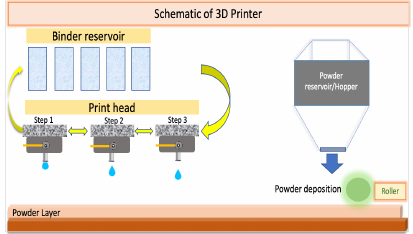
Fig. 1. Schematic of binder jetting 3D printing